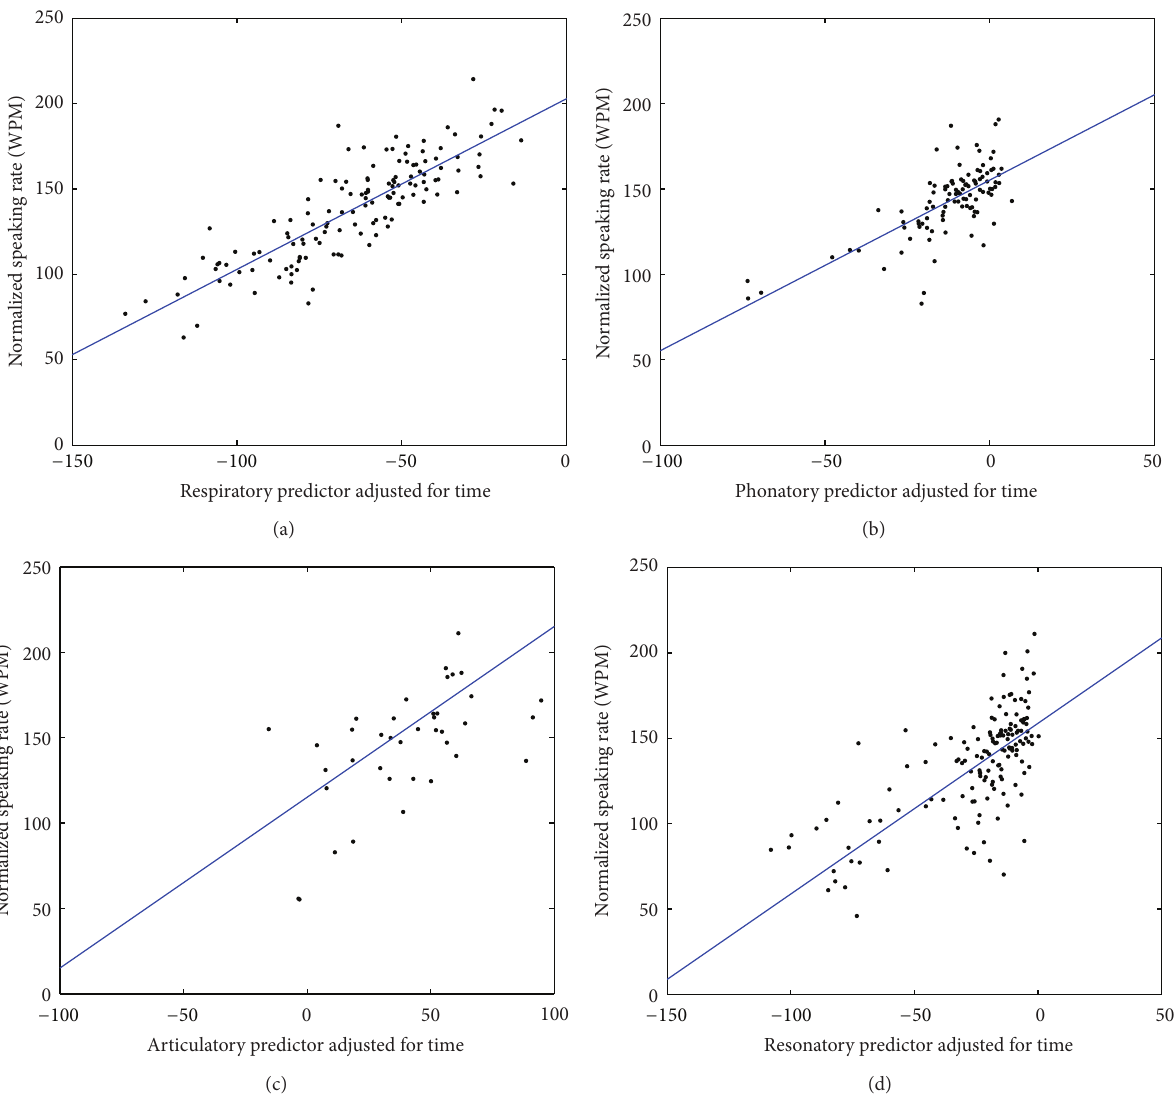
Figure 2: Scatter plots of the relation between speaking rate and each subsystem predictor accounting for time and subject effects: (a) respiratory, (b) phonatory, (c) articulatory, and (d) resonatory. On the 𝑥 -axis is the subsystem predictor adjusted for time, which is the combination of each subsystem predictor and the effect of time on speaking rate. On the 𝑦 -axis is the normalized speaking rate derived by subtracting the subject-dependent random effect from speaking rate. The lines are the linear fits based on the LME